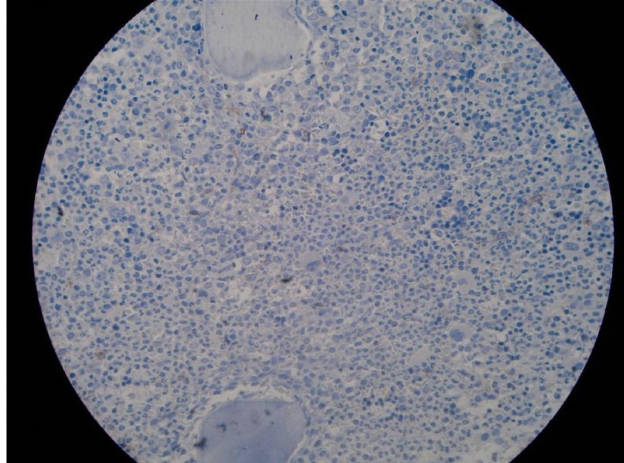
FIGURE 2A - Histological section of normal (degree I) BMB stained immunohistochemically for CD34, 100 x magnification.